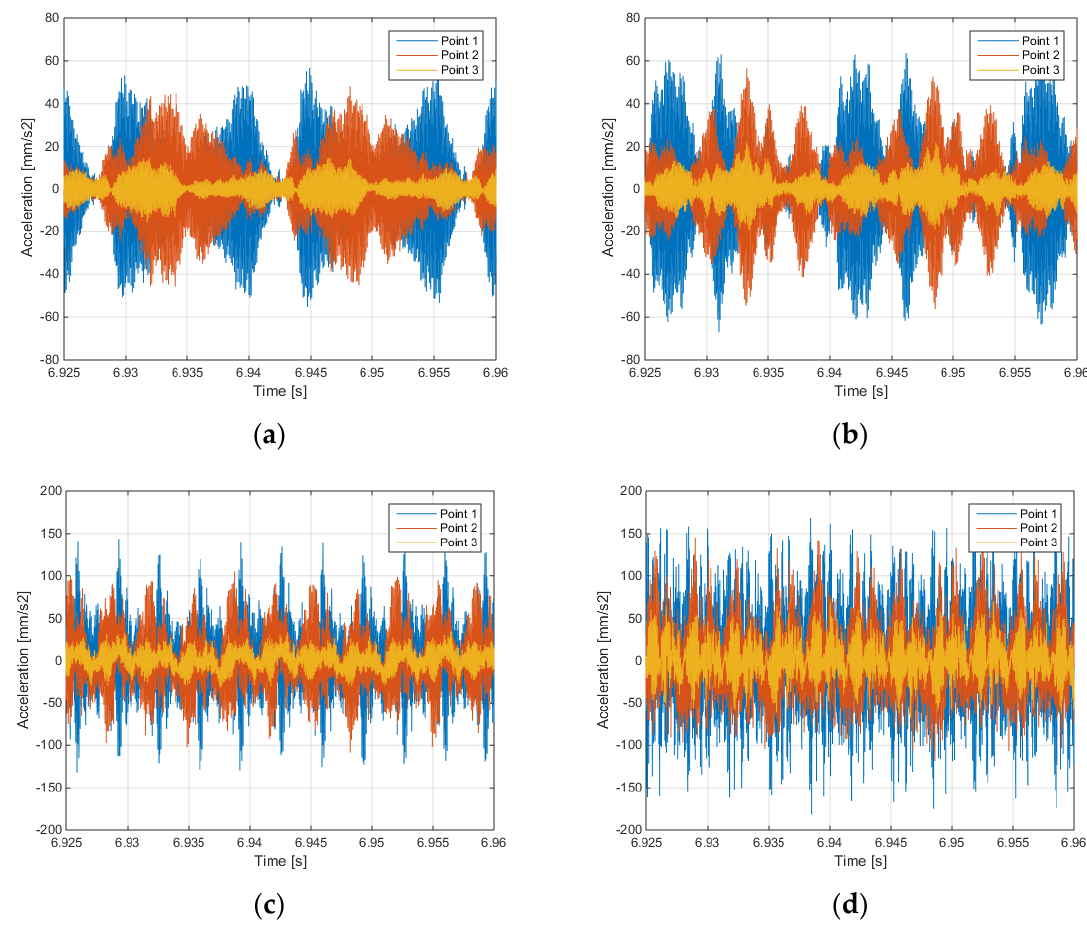
Figure 18. Vibration of the machine at 45 deg current angle: ( a ) 1000 rpm and 20 Nm; ( b ) 1000 rpm and 60 Nm; ( c ) 4500 rpm and 20 Nm; ( d ) 4500 rpm and 60 Nm .